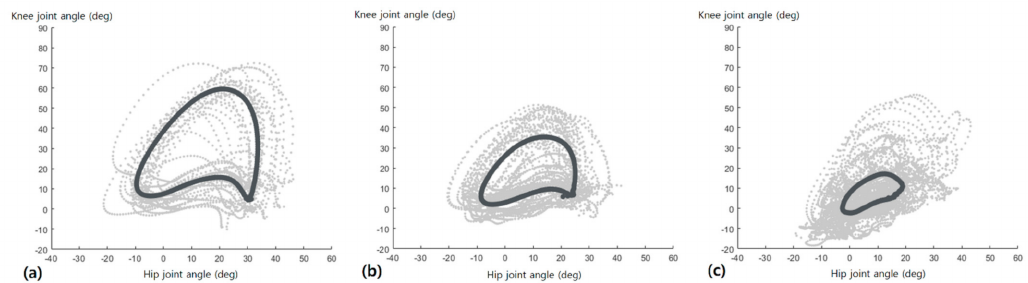
Figure 3. Hip–knee cyclograms of three groups. The mean hip–knee cyclogram is indicated by bold lines, while all hip–knee cyclograms are shown as gray dots. ( a ) Control group; ( b ) Mild stroke group; ( c ) Moderate stroke group.